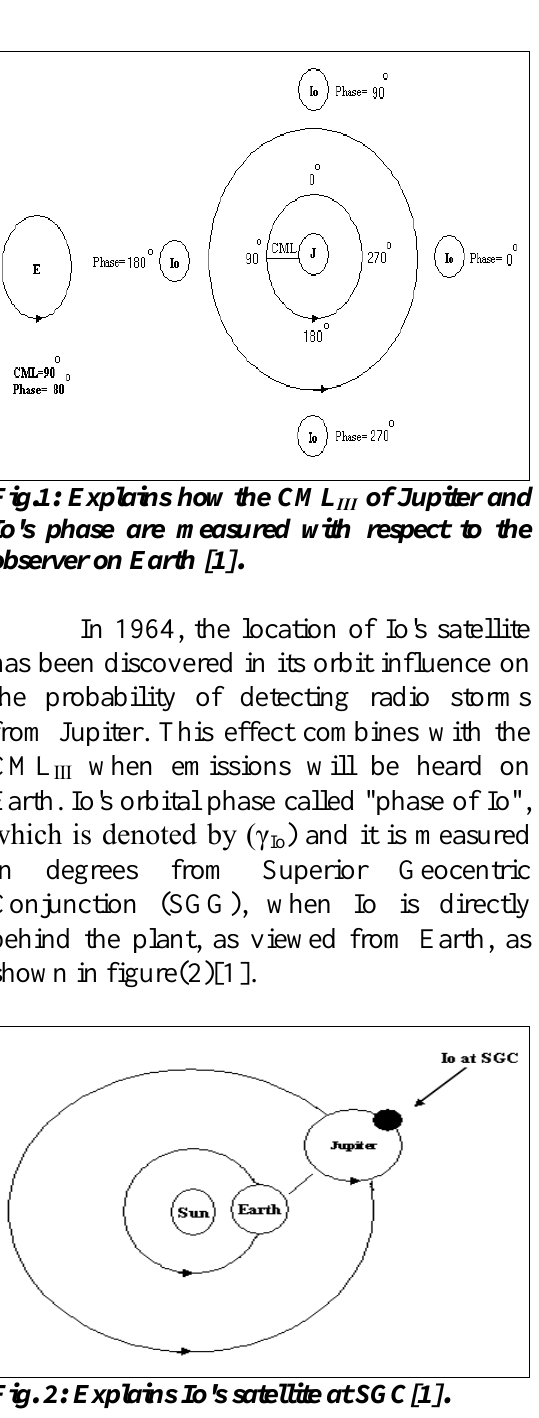
Fig. 2: Explains Io's satellite at